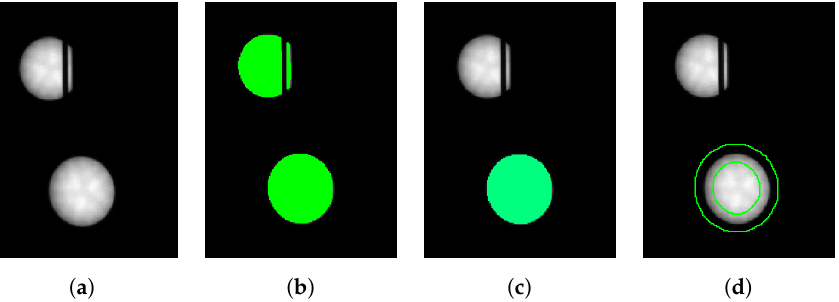
Figure 2. Steps of segmentation of the object points in the image visualized on a cropped gray value image part ( a ). While during threshold segmentation ( b ), interrupted LED markers are still detected, they are eliminated when applying the selection criteria ( c ). Morphology is used to determine the edge regions of the LED markers ( d ).